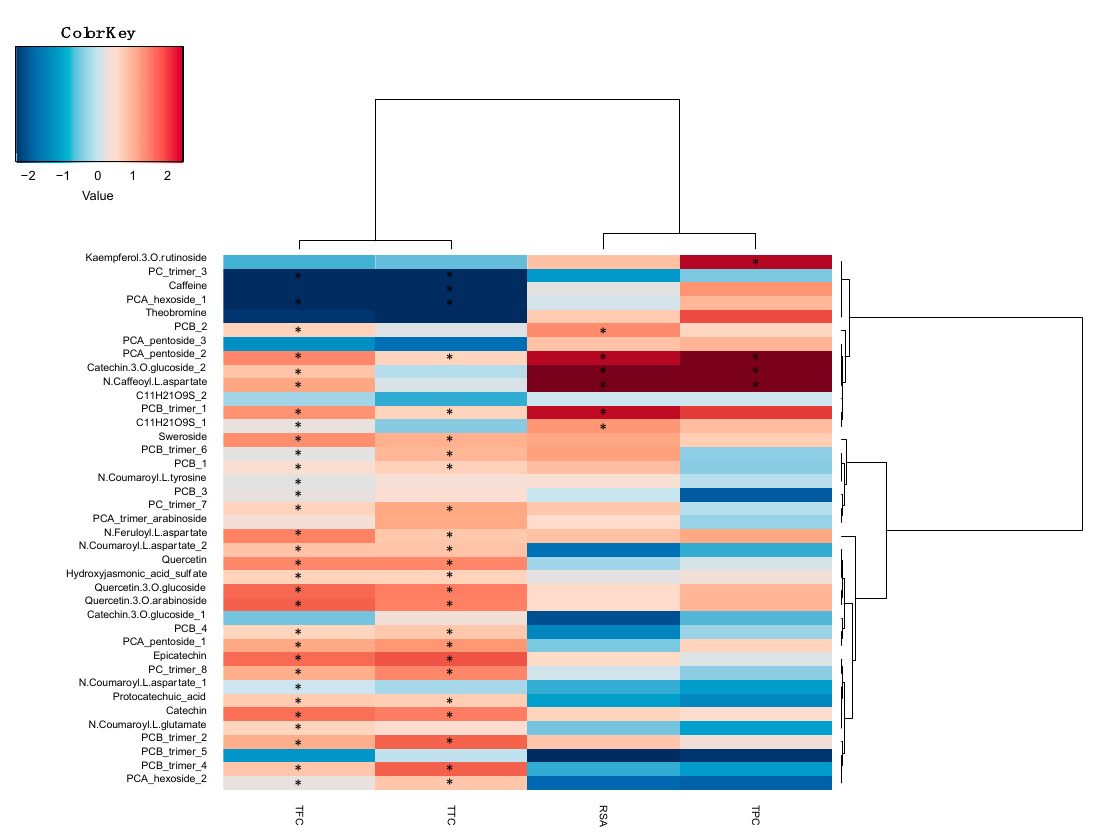
Figure 3. Correlation between the abundance of bioactive compounds and spectrophotometric assay responses. Rows and columns are clustered by Ward linkage hierarchical clustering. The intensity of the colors represents the degree of correlation between the samples and chemical compounds as measured by Spearman’s correlations. Asterisks denote significant correlations after p value corrections (FDR < 0.05).